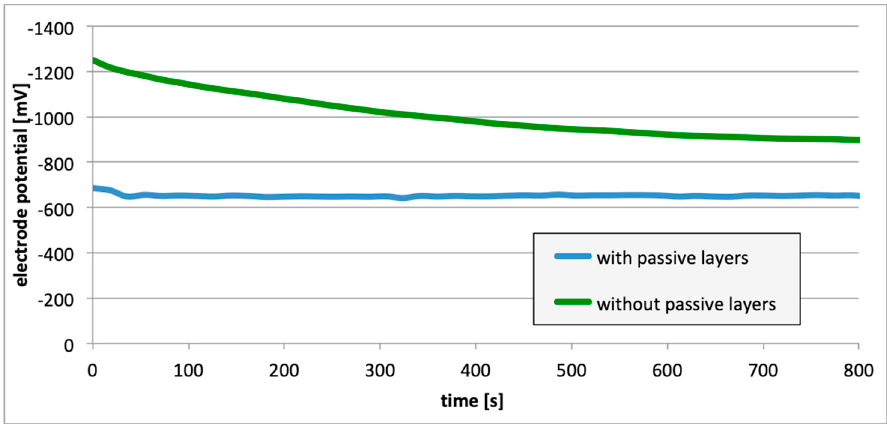
Figure 14. Electrode potential change following removal of passive layers (EN AW-5754).